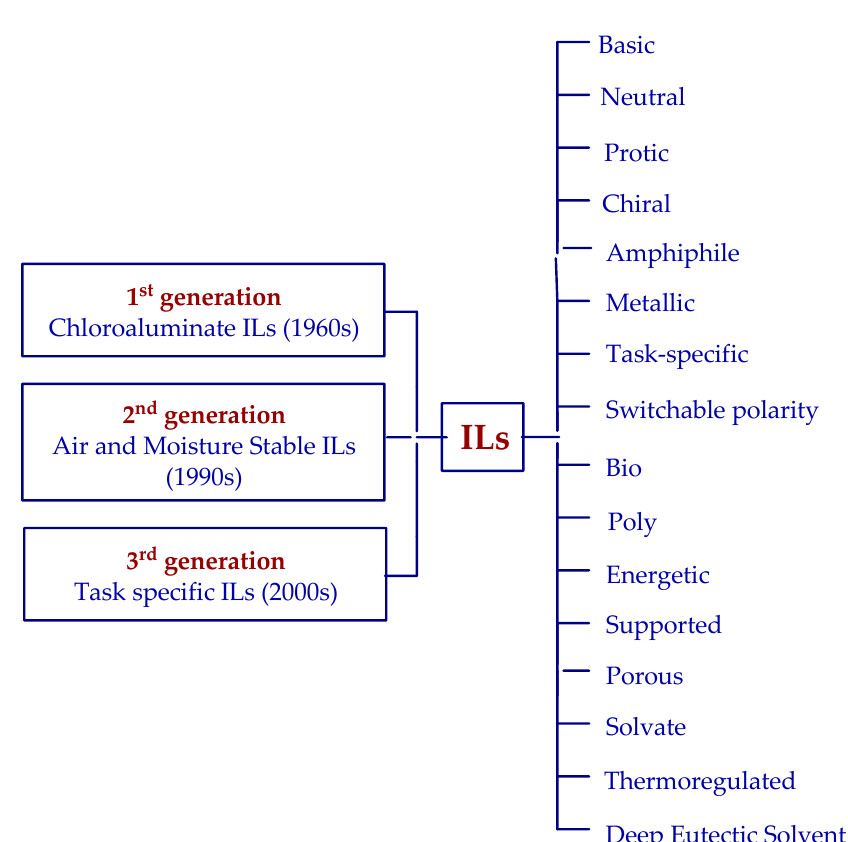
Figure 2. Structural evolution of the respective generations of ionic liquids.